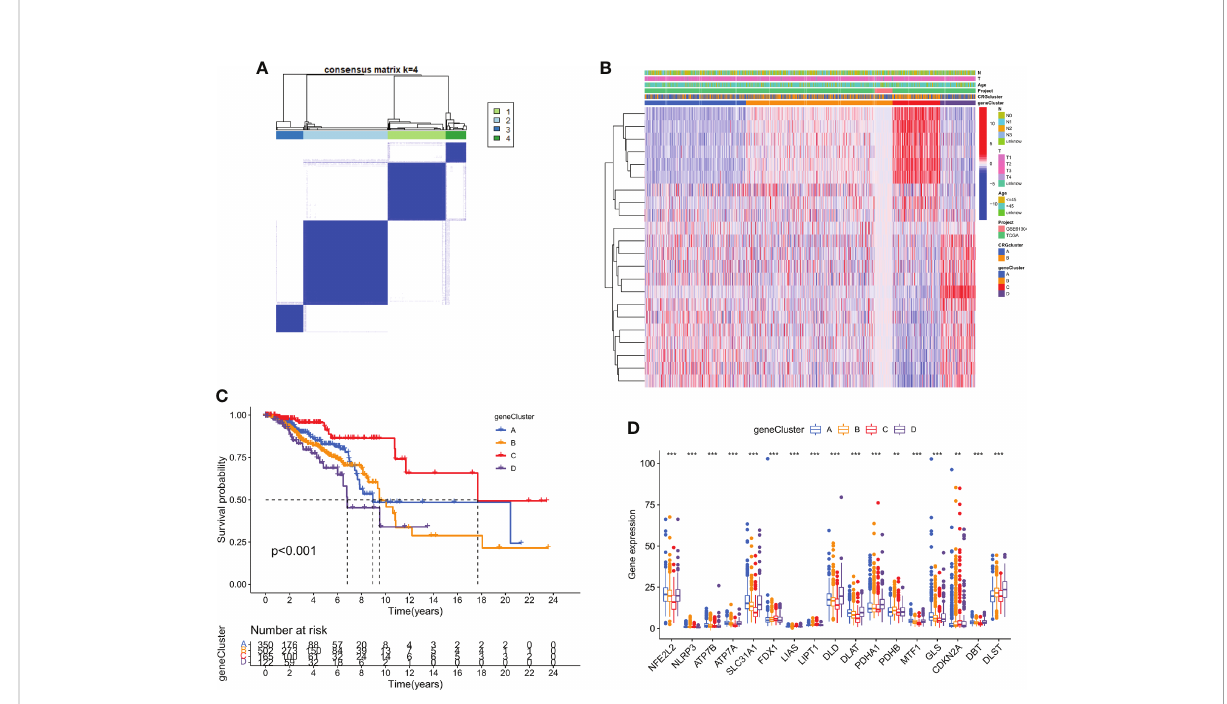
FIGURE 4 DEGs are used to identify gene subtypes. (A) Heatmap of the consensus matrix de fi ning four clusters ( k = 4). (B) Differences in clinicopathologic characteristics among the four gene subtypes. (C) The four gene subtypes' Kaplan-Meier OS curves. (D) Variations in the expression of ten CRGs across four gene subtypes. **p < 0.01, ***p < 0.001.